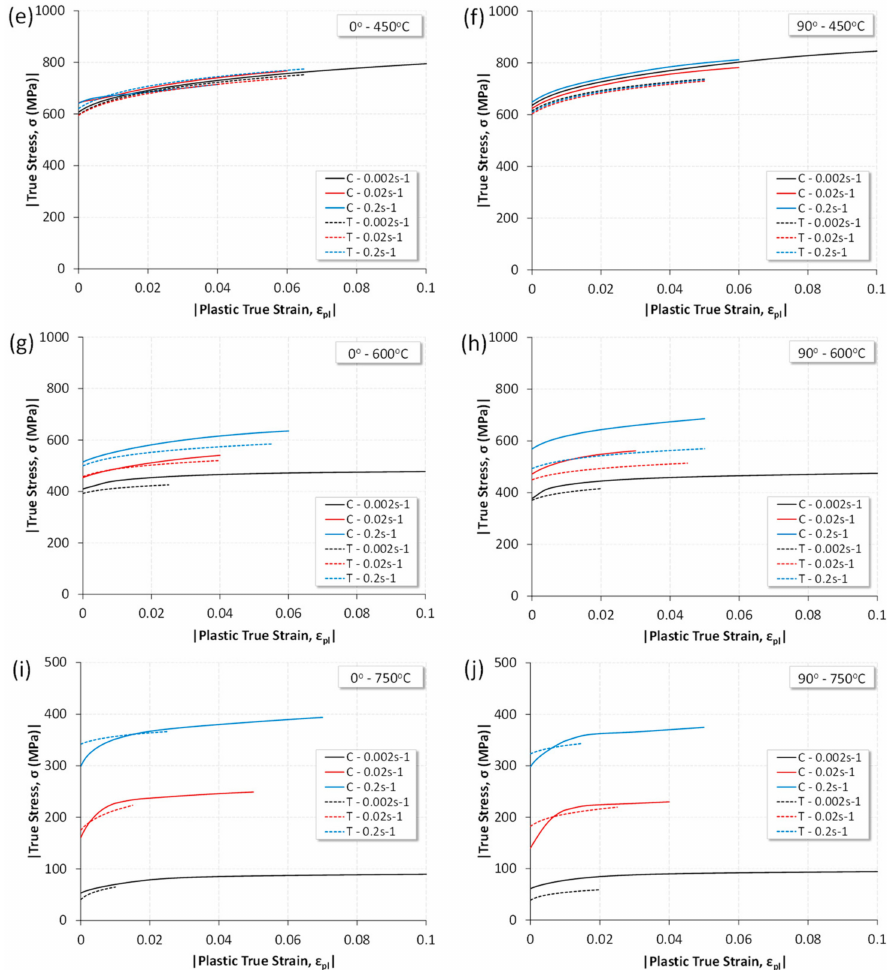
Figure 13. Tension and compression behavior of Ti6Al4V at temperatures of 25, 300, 450, 600, and 750 ◦ C, and strain rates of 0.002, 0.02, and 0.2 s − 1 . ( a , c , e , g , i ) Mechanical behavior in rolling direction